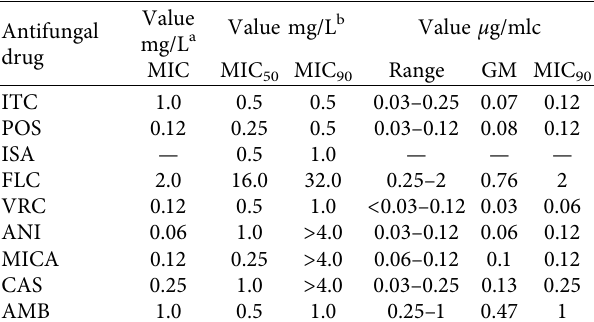
Table 1: Antifungal sensitivity phenotype of Candida pararugosa strain from the patient compared with pattern described in epi- demiological surveys of